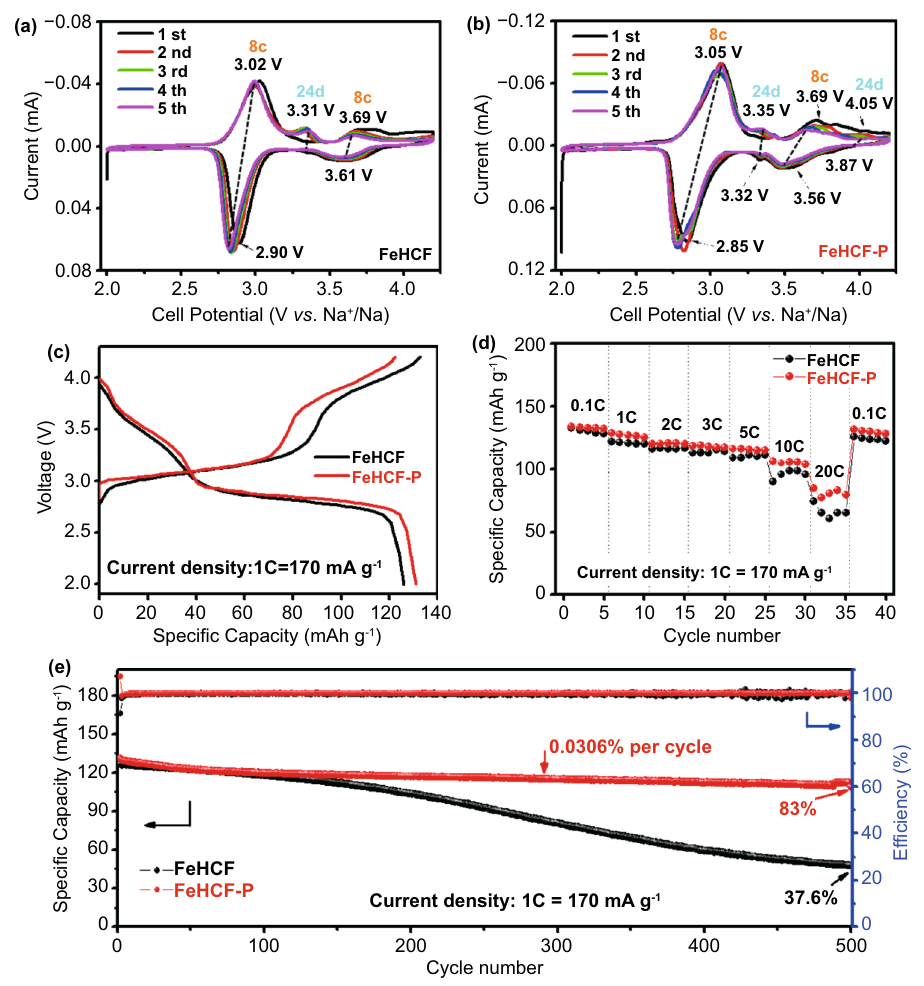
Fig. 2 Cyclic voltammetry profiles of a FeHCF and b FeHCF-P at a scanning speed of 0.2 mV s −1 . c Charge–discharge curves at 1 C. d Rate performance and e cycling performance under 1 C of FeHCF and FeHCF-P